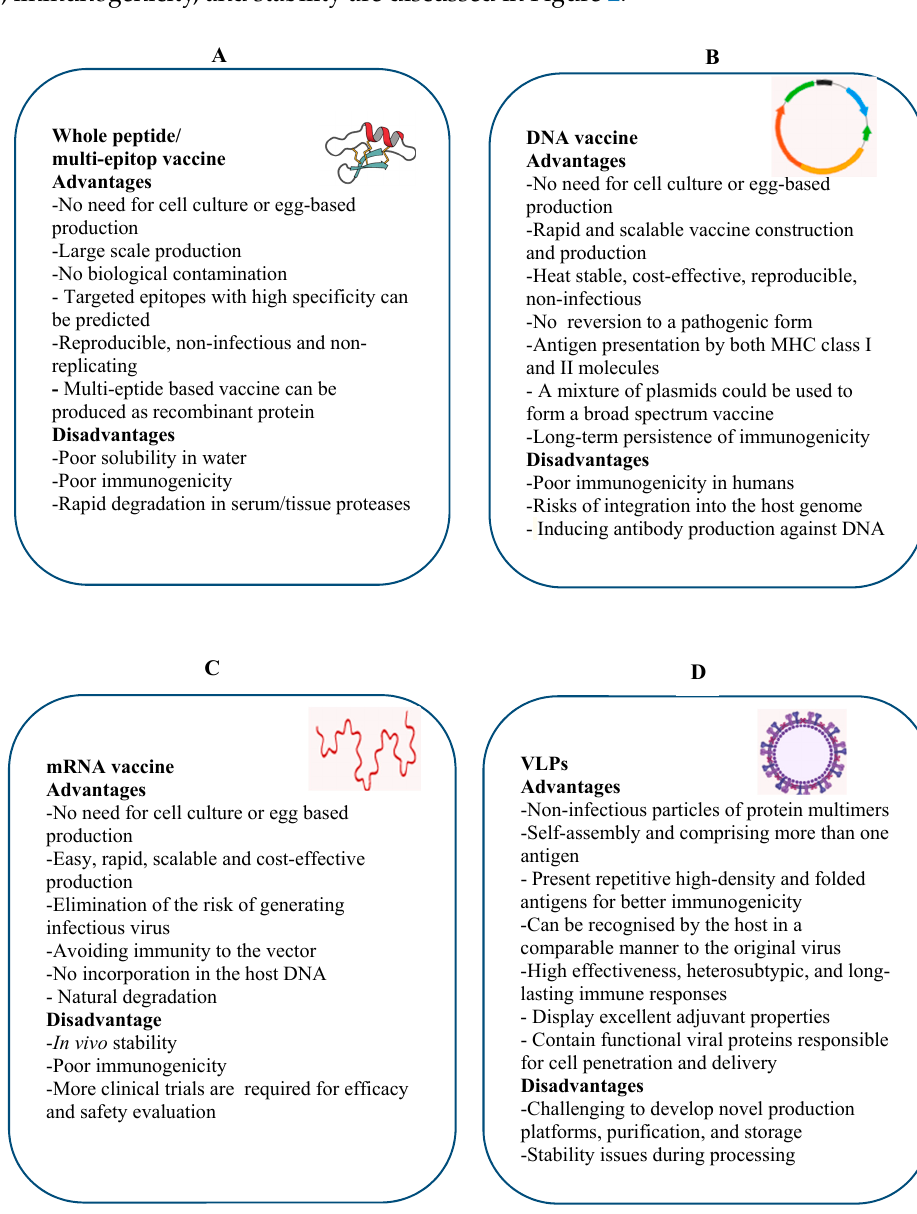
Figure 2. Advantages and disadvantages of whole peptide / multi-epitope ( A ), DNA ( B ), mRNA ( C ), and virus-like particles (VLP) ( D ) vaccine platforms for developing a novel universal influenza vaccine: All four vaccine platforms are able to induce humoral and cellular immune responses.